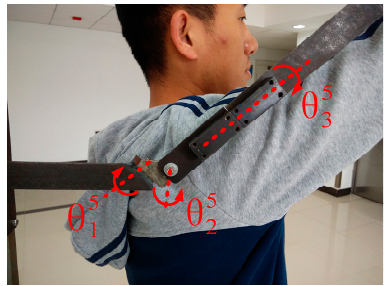
Figure 20. Singularity position of the 5 ‐ DOF exoskeleton prototype.